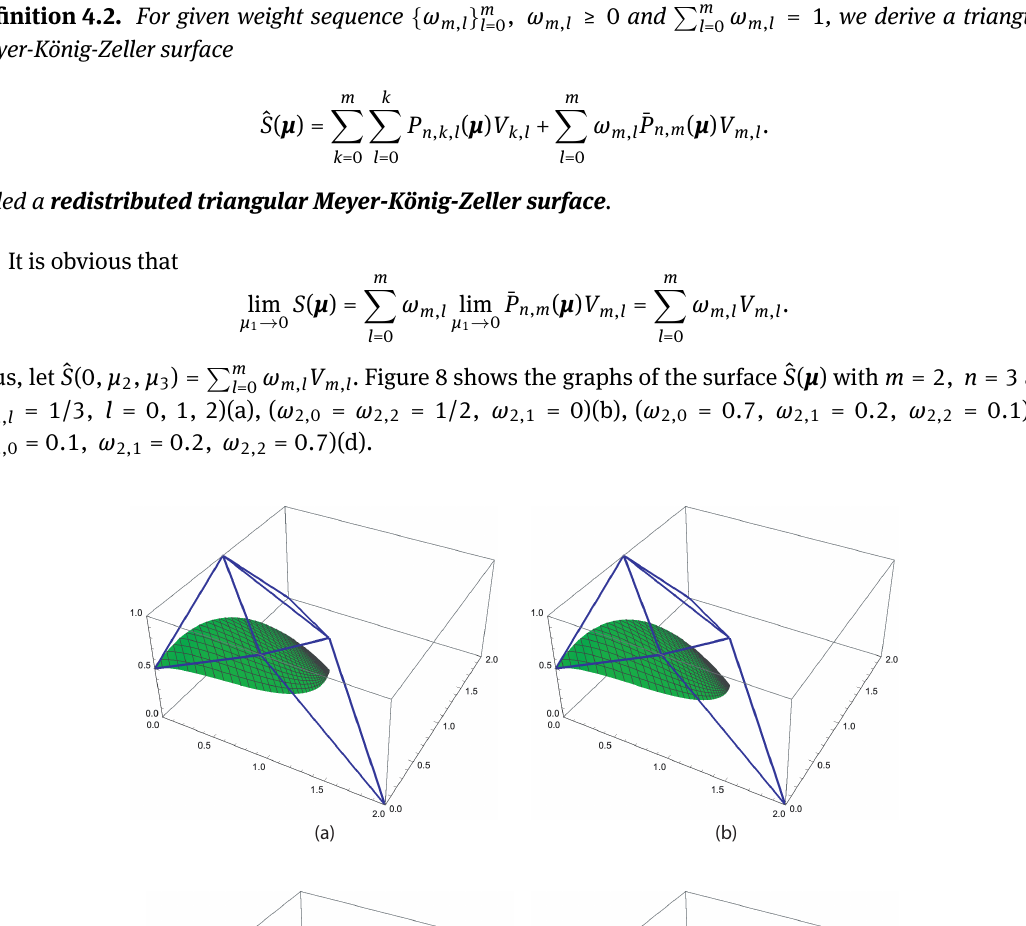
Theorem 4.1. Redistributed triangular Meyer-König-Zeller surfaces retain the properties of triangular Meyer- König-Zeller